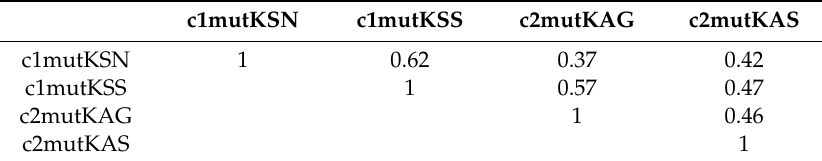
Figure 7. Betweenness centrality of the node for each residue. Table 4. Square inner product of betweenness centrality.